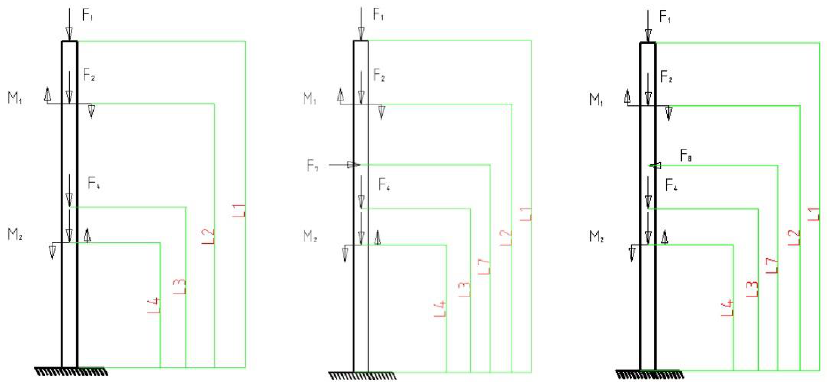
Figure 2. The load analysis diagram of column mechanism under static state, acceleration state and deceleration state.